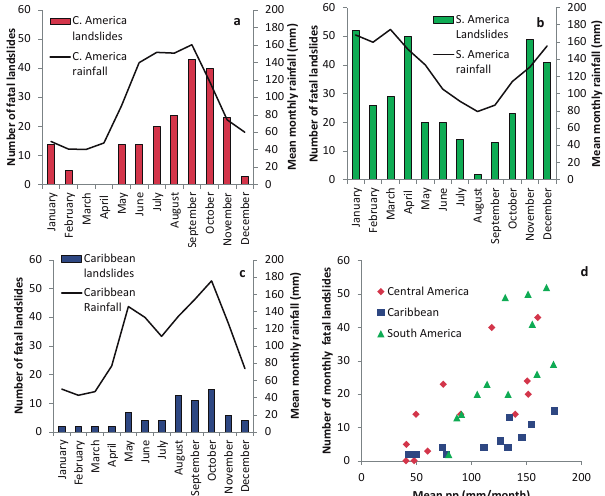
Figure 6. Monthly distribution of landslides in 2004–2013 and FIGURE 6 mean monthly precipitation in the same period (GPCC 1 ◦ data set, Schneider et al., 2011b) in (a) Central America, (b) South America and (c) the Caribbean; and (d) relationship between fatal landslides and amount of monthly rainfall for the three